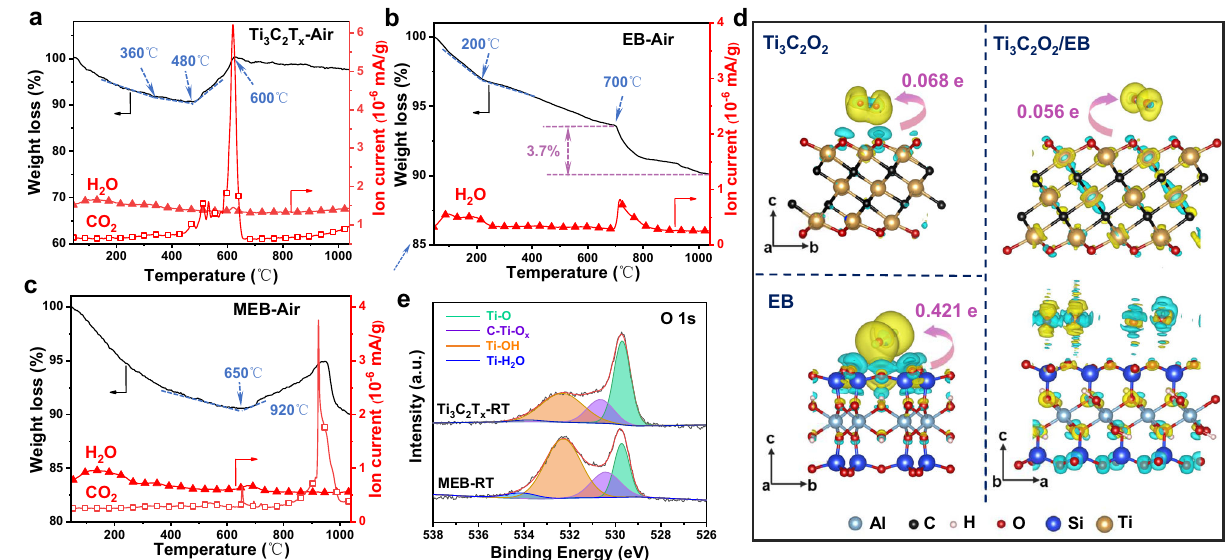
Fig. 3 | Mechanism ofhigh-temperature resistance in MEB. Thermalgravimetric (TG)curvesintheairwithmassspectrometryanalysis(MS)fortheatomicmassunit (amu)of18/H 2 Oand44/CO 2 for( a )Ti 3 C 2 T x ,( b )EB,and c MEB. d Thechargedensity difference plots for the stable con fi gurations of one O 2 adsorbed on Ti 3 C 2 O 2 , EB, and Ti 3 C 2 O 2 /EB heterostructure. In the heterostructure, EB is subject to saturated